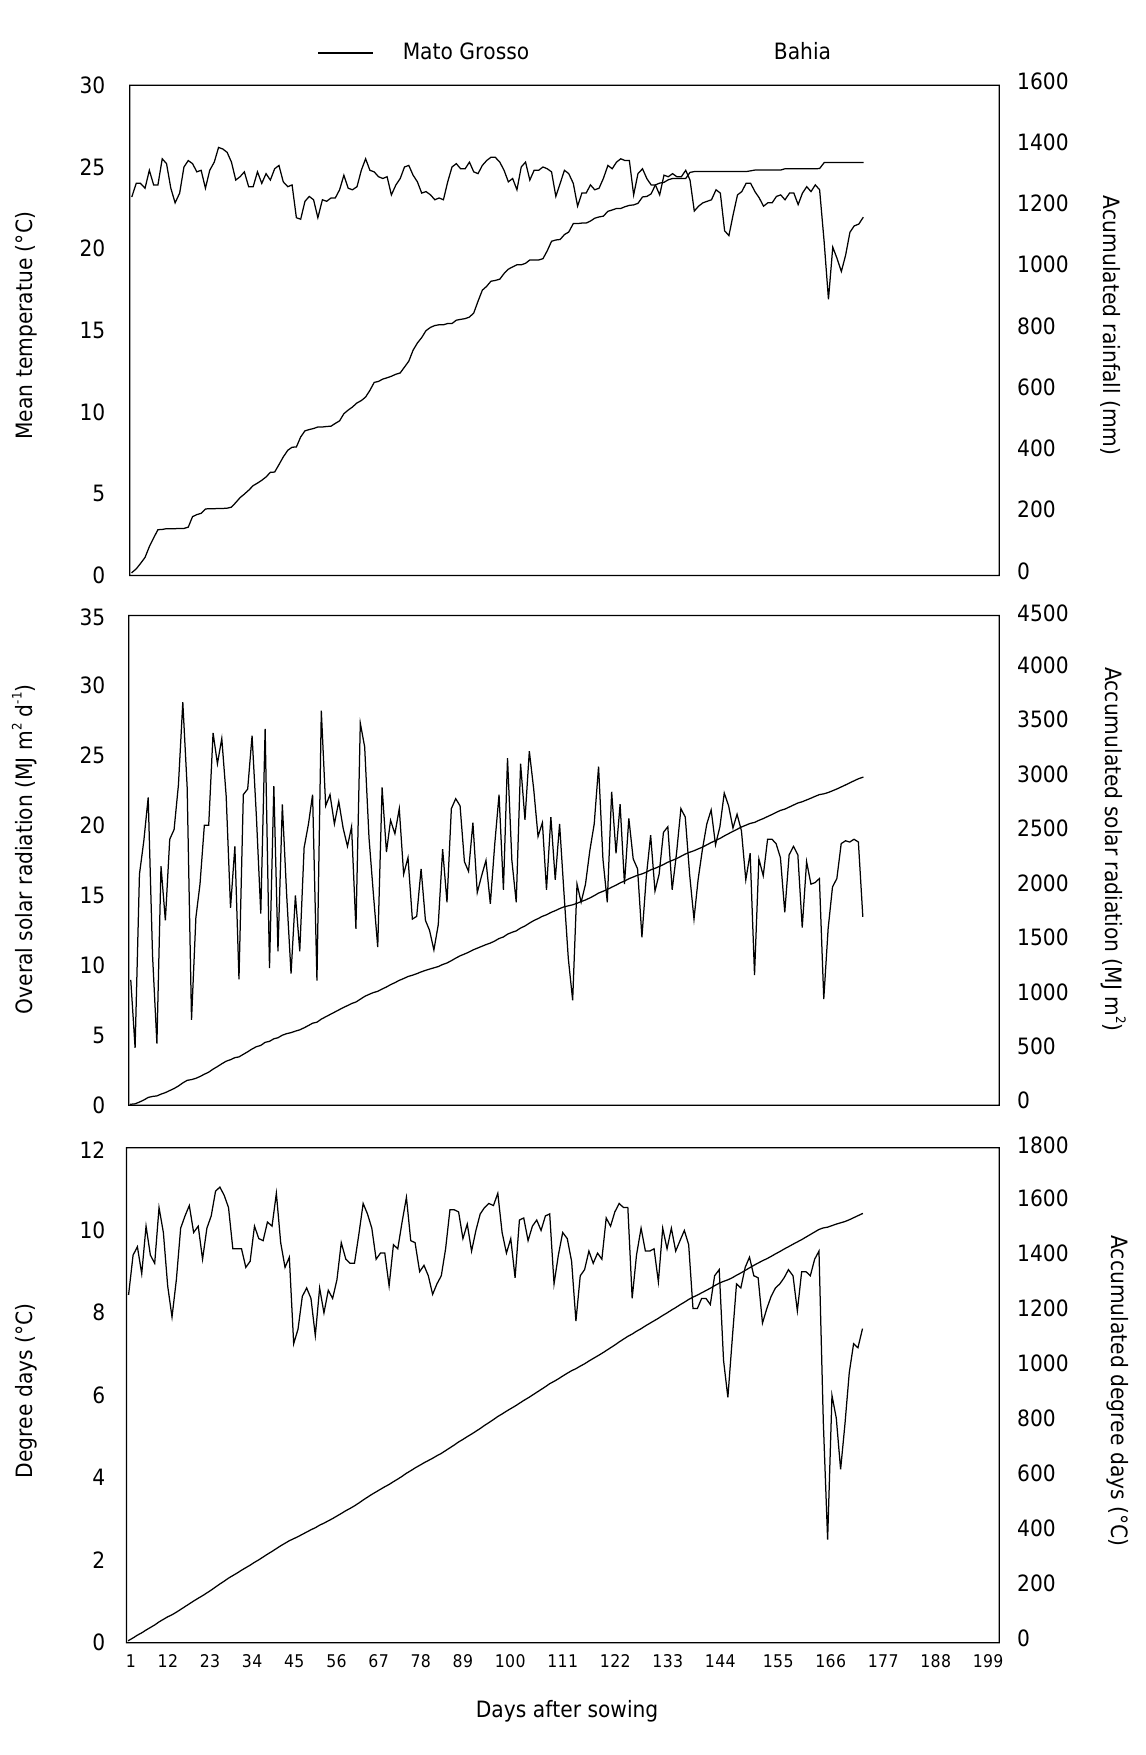
Figure 1. Variation in climatic parameters for the experimental sites from the time of planting to the harvest period for the experiments. Degree days calculated as Σ [(T + t)/2 - 15], where T is the daily maximum temperature (°C); t is minimum daily temperature (°C); and 15 is the base temperature (°C), according to Rosolem